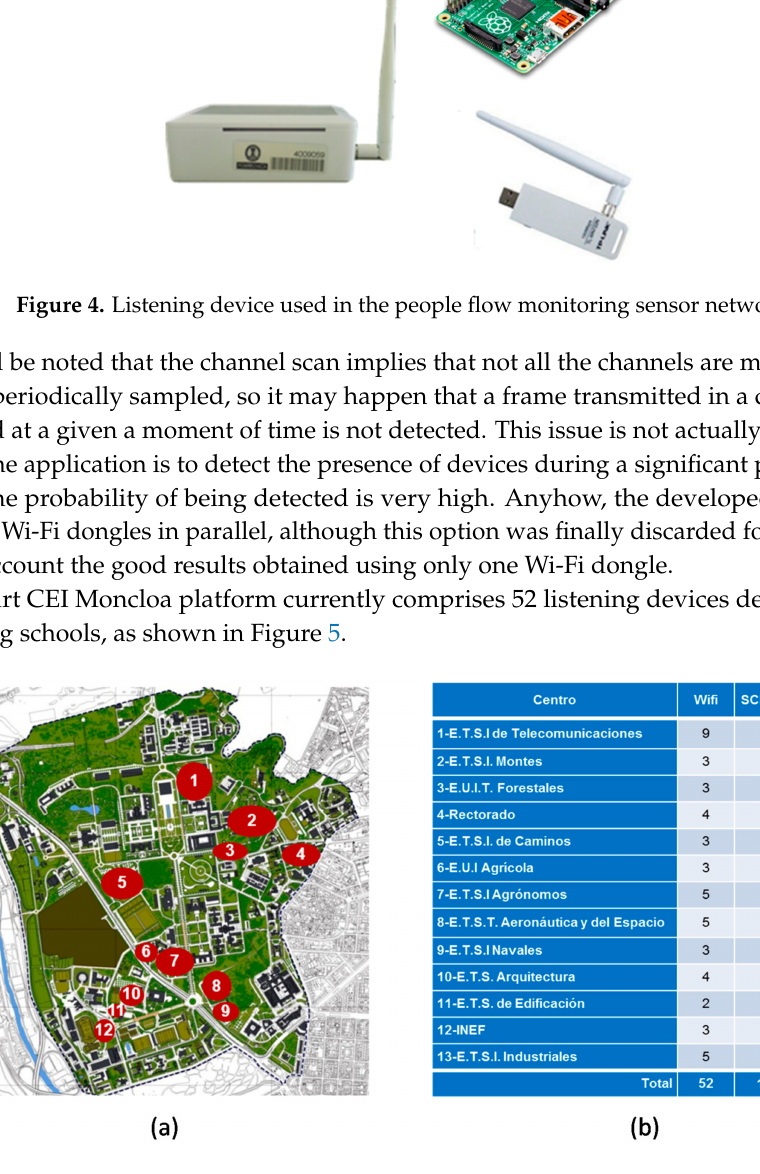
Figure 5. Summary of the sensors deployed in the Smart CEI Moncloa (November 2017): ( a ) Location of the schools within the Campus; ( b ) number and type of sensors per